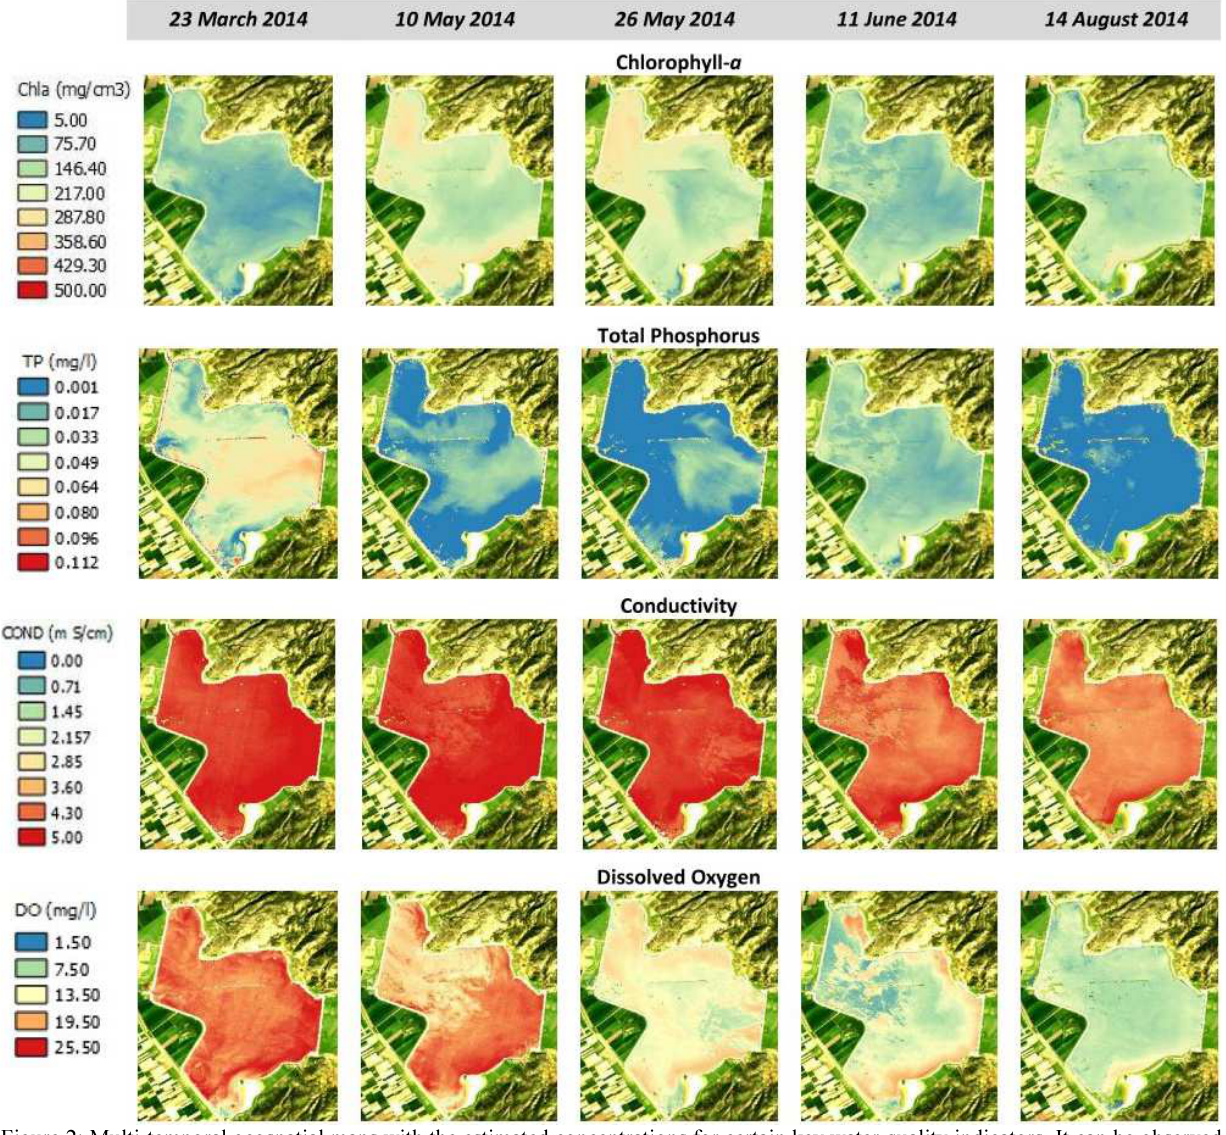
Figure 2: Multi-temporal geospatial maps with the estimated concentrations for certain key water quality indicators. It can be observed that chlorophyll -a presented slight variations throughout the year. TP reached certain peaks in March and then dropped to lower rates. Conductivity resulted in high rates throughout the year although from June and afterwards there was a minor decrease. Dissolved oxygen reached a maximum in March (as TP) and then decreased